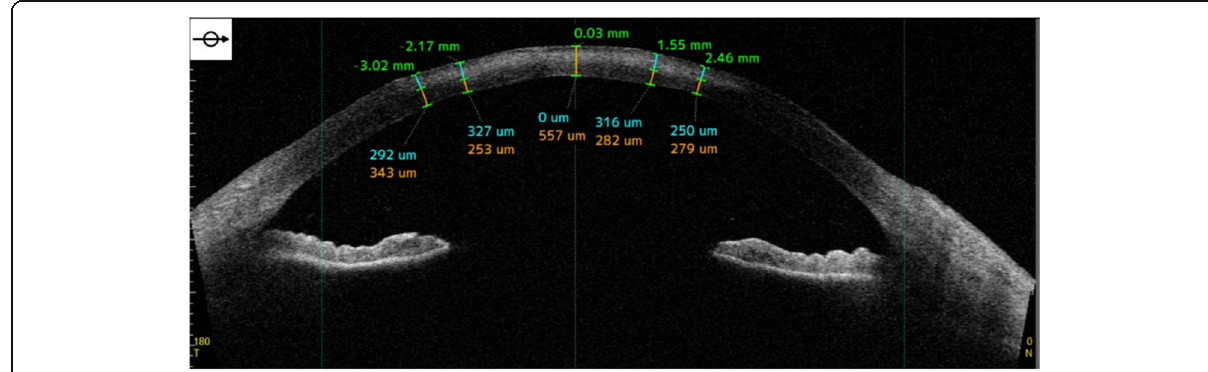
Fig. 3 Anterior-segment optical coherence tomography (AS-OCT) of the right eye showing infiltrates and increasing hyperreflectivity in the stromal bed. The numbers above the cornea correspond to eccentricity from the central cornea in mm; numbers below the cornea represent the depth of the infiltrates in the stromal bed in